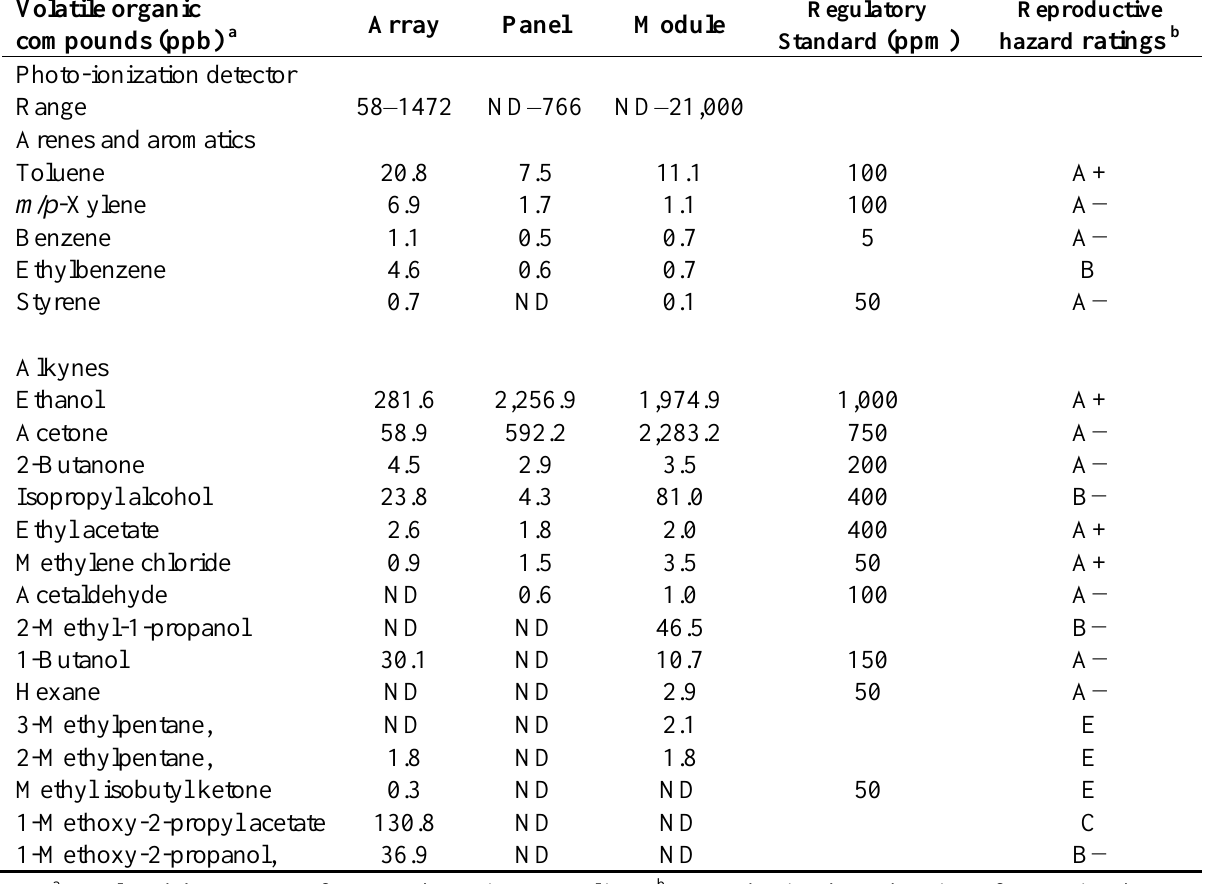
Table 1. Air sampling levels of volatile organic compound with potential reproductive hazards by three areas of